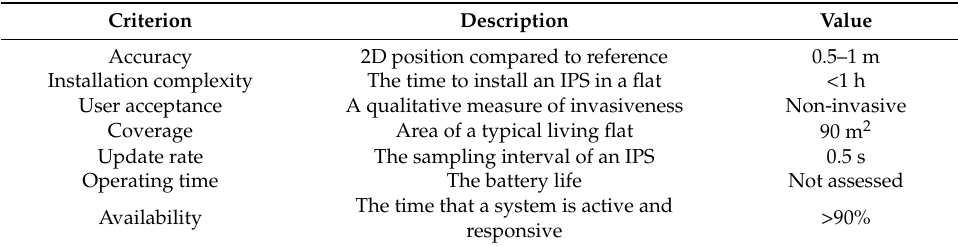
Table 2. Summary of requirements for the elderly care